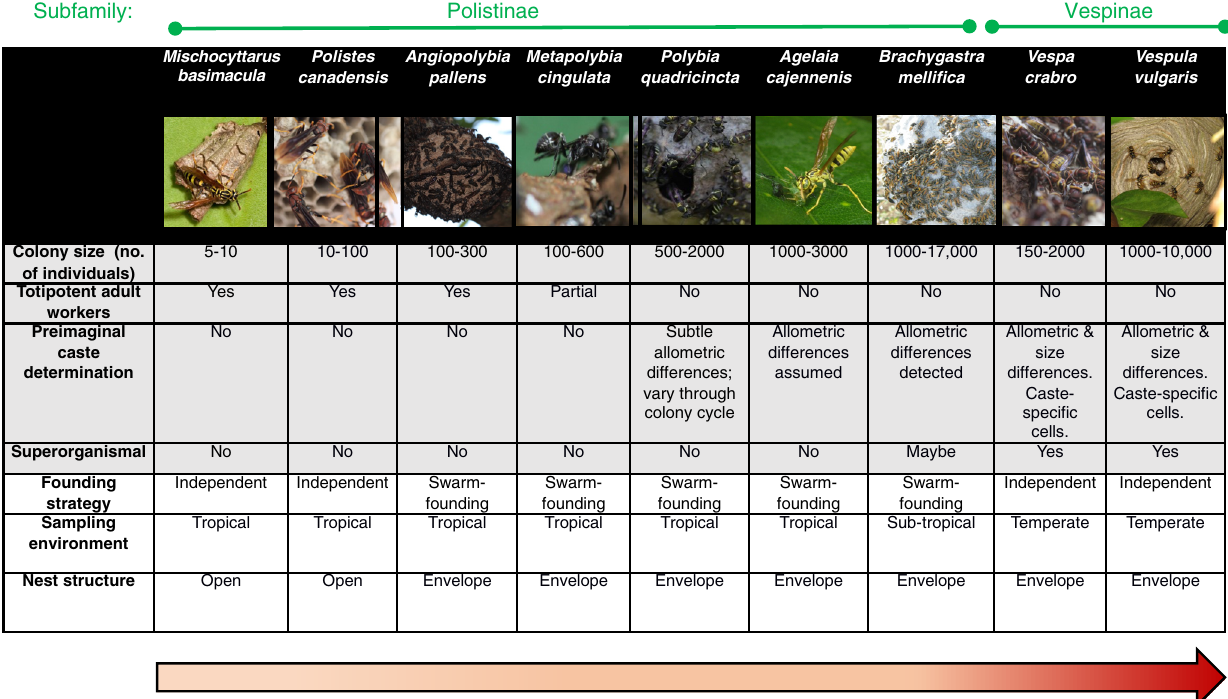
crabro and Vespula vulgaris (see Methods for further details of species choice). Where data on evidence of morphological castes was not available from the lit- erature, we conducted morphometric analyses of representative queens and workers from several colonies per species (see Methods; Supplementary Data 8). With respect to life-history traits, all social wasps are generalist predators and so they share similar diets 56 . Other traits vary across species: e.g. some species foundingnestsasasinglequeen( ‘ independentfounding ’ )whilstothersfoundnew nests as a group of queen(s) with workers ( ‘ swarm founding ’ ); some species have open nestswhilst othershave anenvelope. All Polistinesincluded in this study are tropical, and all Vespines are temperate. The latter two traits are confounded by level of sociality and thus their in fl uence on gene expression could not be disen- tangled. Image credits: M. basimacula (Stephen Cresswell). A. cajennesis (Gionor- ossi; Creative Commons); V. vulgaris (Donald Hobern; Creative